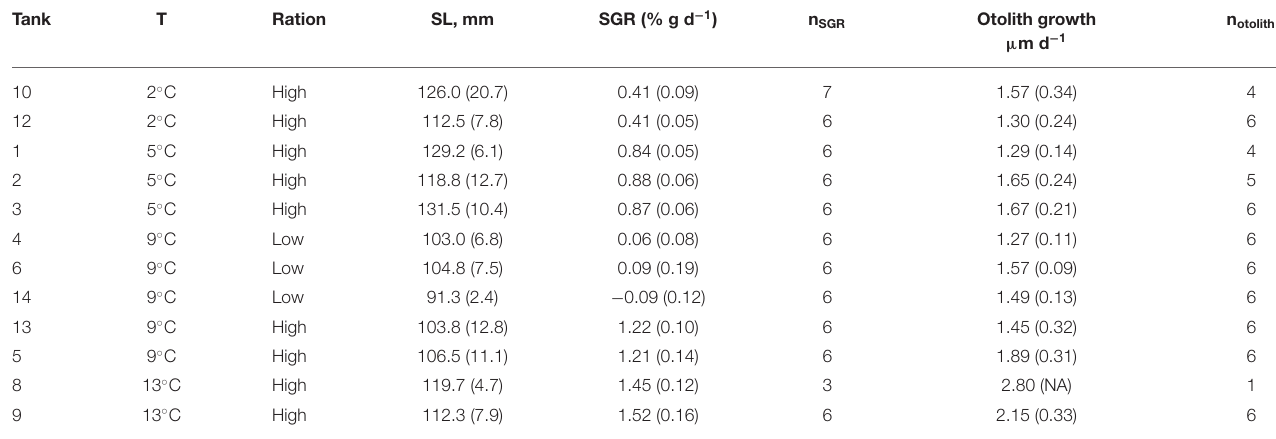
TABLE 4 | Tank number, water temperature (T), ration, and mean (SD) fish size at end of the experiment (standard length, SL) and specific growth rate (SGR) and otolith growth rate during the experiment.